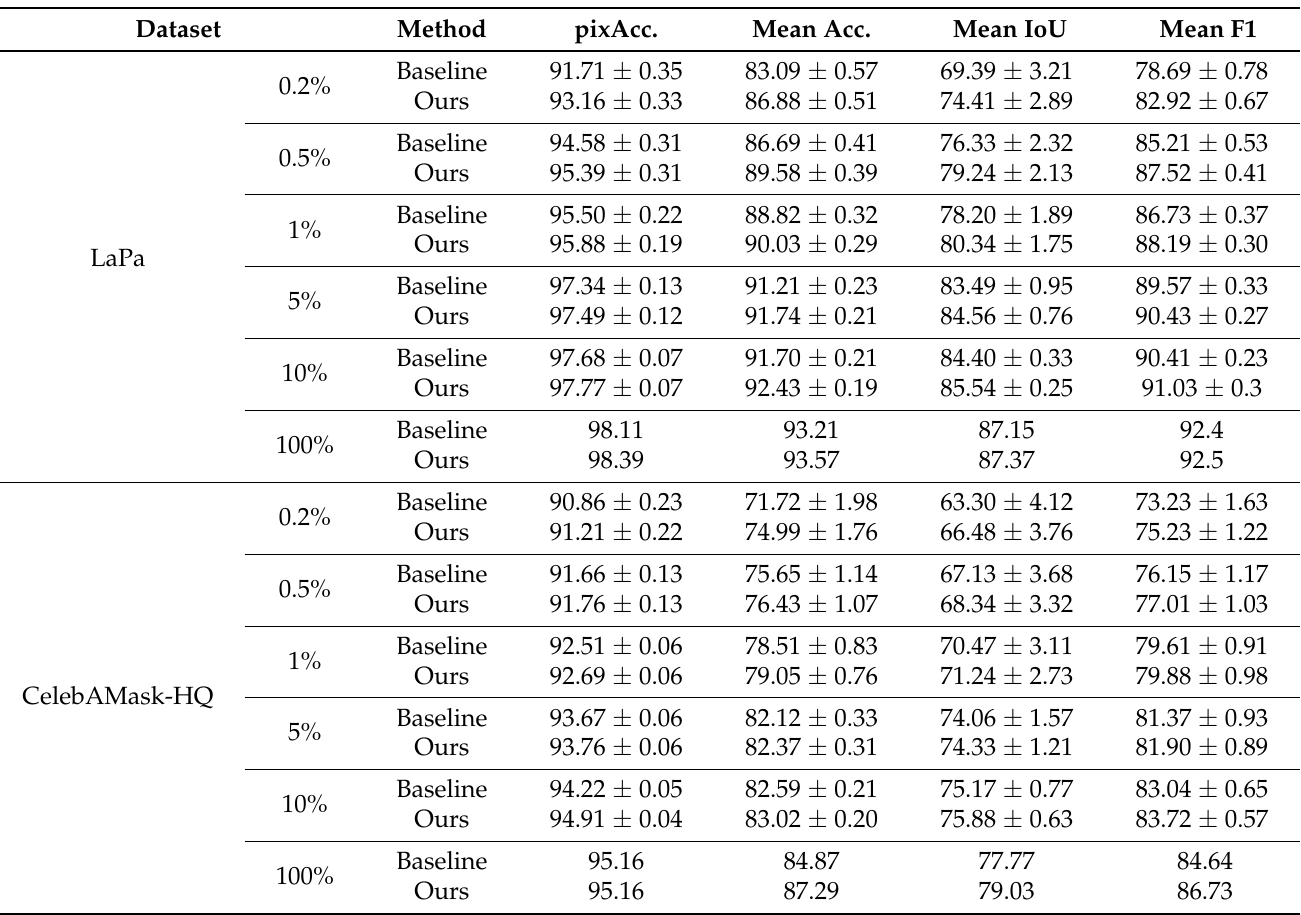
Table 1. Performance comparison between the baseline (without the masked self-supervised learning) and our approach in terms of pixel accuracy, mean accuracy, mIoU and mean F1 score with state-of- the-art methods on the LaPa and CelebAMask-HQ test set.